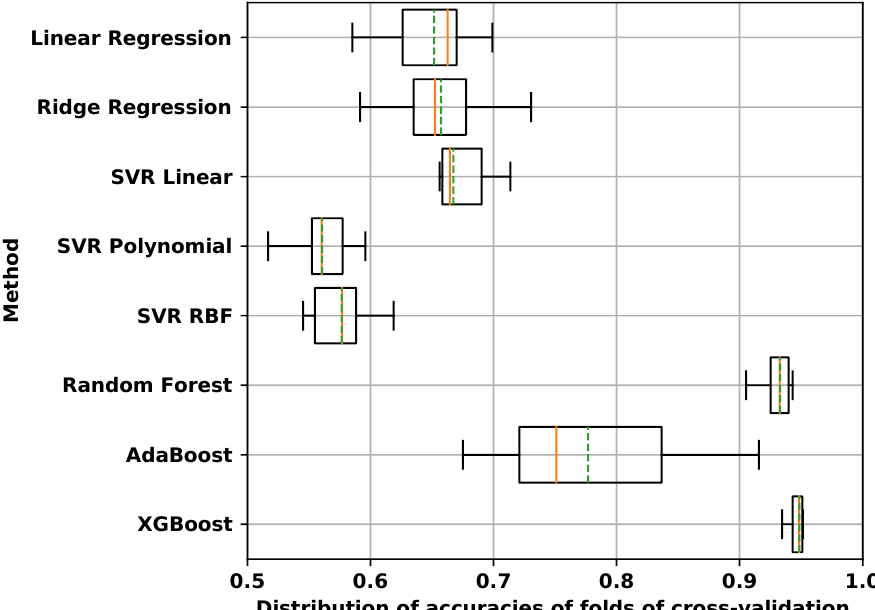
Figure 4. Comparison of ± 1 two-fold dilution accuracy of regressors in 10 folds of cross-validation on predicting MIC of ampicillin for Salmonella enterica with 4-mers of amino acid. In each box plot, the whiskers represent the maximum and minimum. The boxes represent the first and the third quartiles. The orange line represents the median and the green dashed line represents the